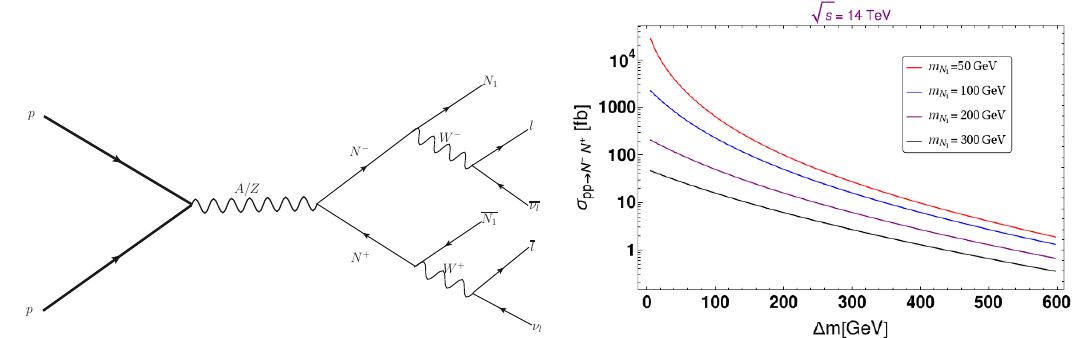
Figure 19 . [Left] Feynman diagram for signal process pp opposite sign dilepton plus missing energy ( ‘ + ‘ (cid:0) + ( =E T )) events. [Right] Variation in production cross section, (cid:27) pp ! N + N (cid:0) with (cid:1) m (= m N (cid:6) at (cid:12)gure inset] for centre-of-mass energy p s = 14 TeV at